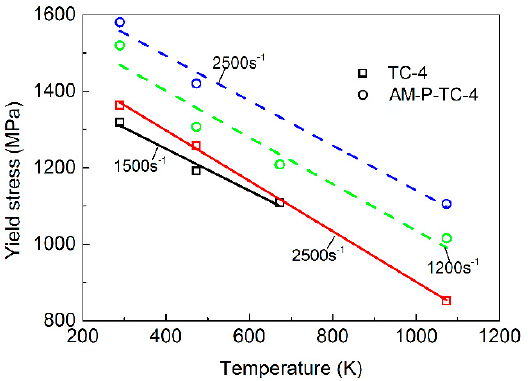
Figure 10. Relationship between material yield strength and initial environment temperature.